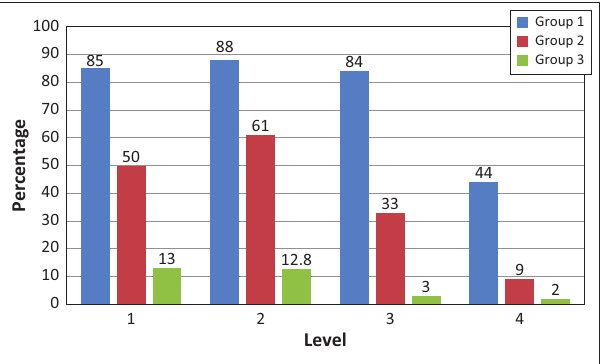
FIGURE 1: Student groups’ average Van Hiele levels of geometric thought on the questions.